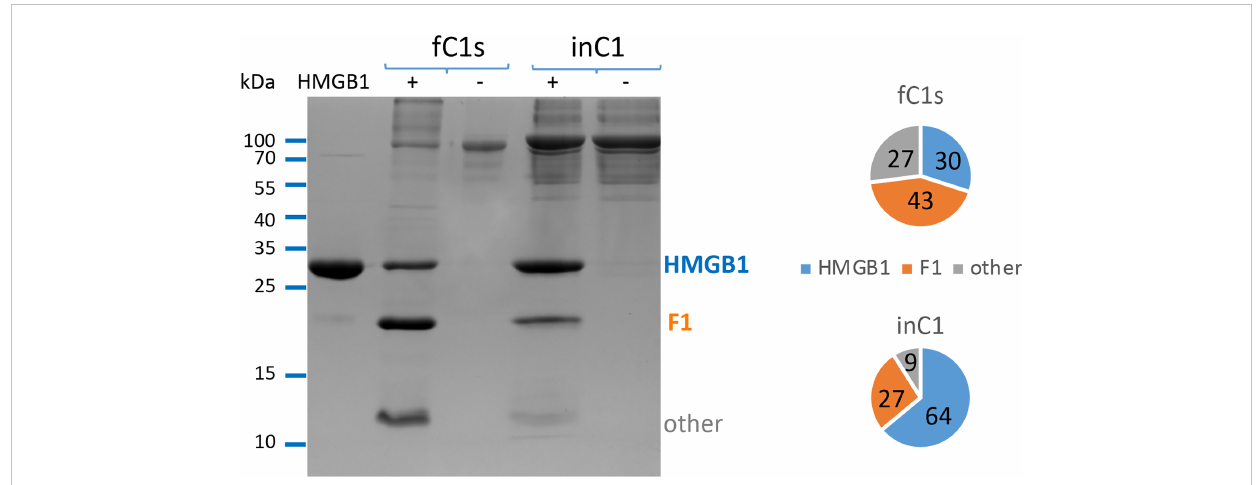
FIGURE 2 Free C1s (fC1s) cleaves HMGB1 more ef fi ciently than C1s inside the C1 complex (in C1). The different proportions of remaining HMGB1 (blue), fragment F1 (orange) and other cleavage products (grey) are illustrated using a representative SDS-PAGE analysis performed at 10% E/S ratio